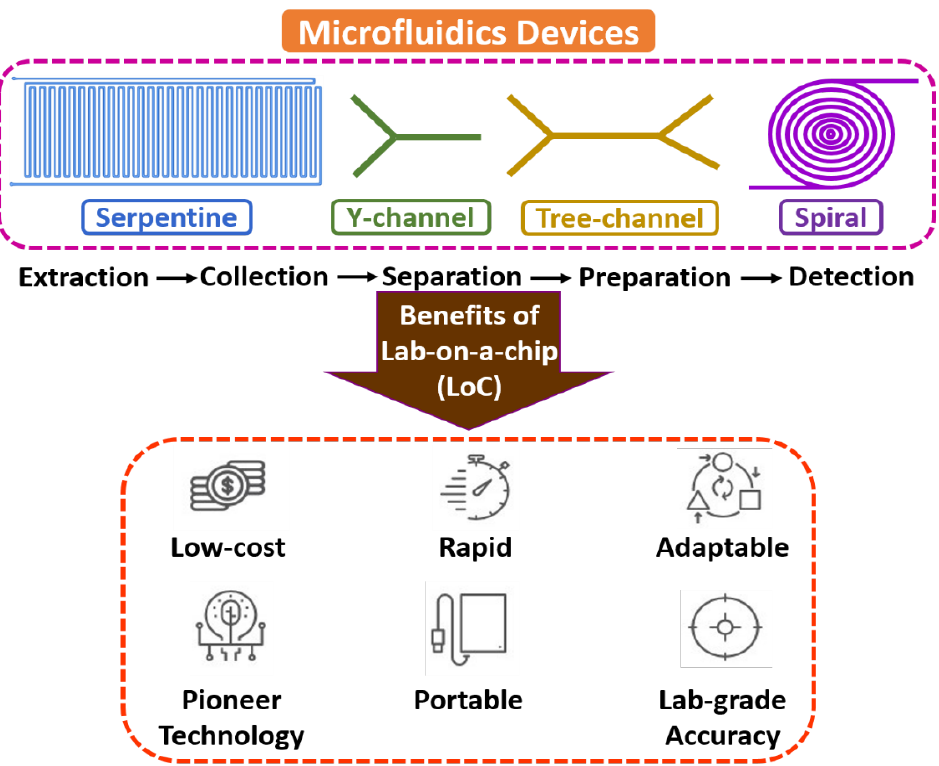
Figure 1. Fundamentals of microfluidic devices.